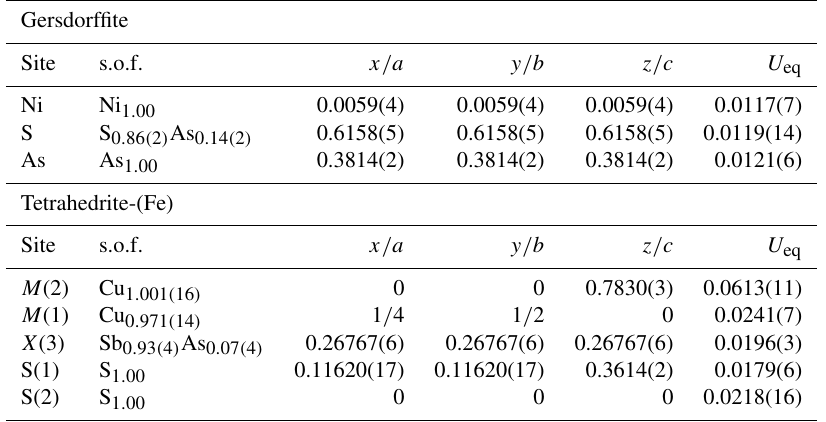
Table 4. Sites, site occupancy factor (s.o.f.), fractional atomic coordinates, and equivalent isotropic displacement parameters (in Å 2 ) for gersdorffite and